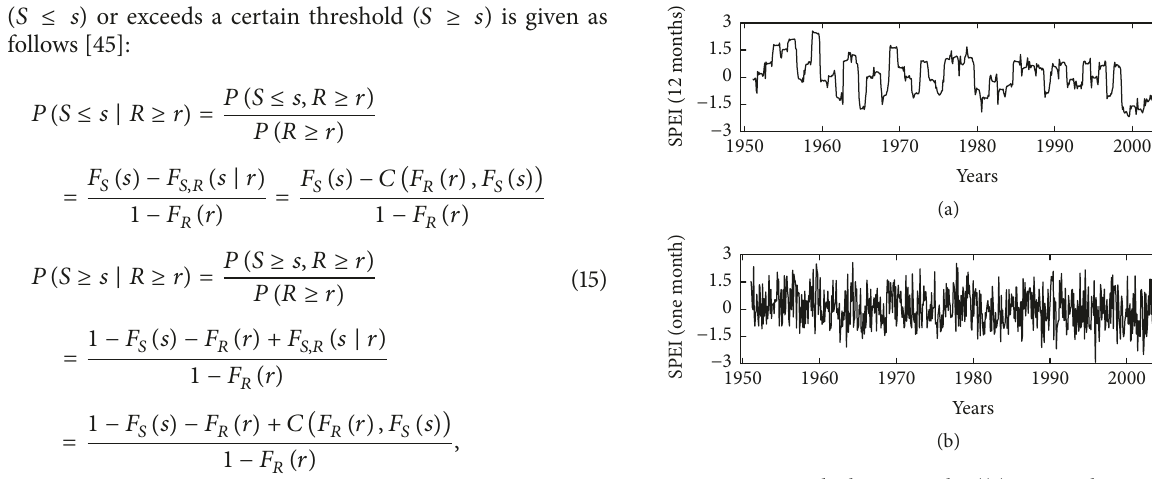
Figure 2: SPEI calculation results ((a) 12-month SPEI and (b) 1- month SPEI).